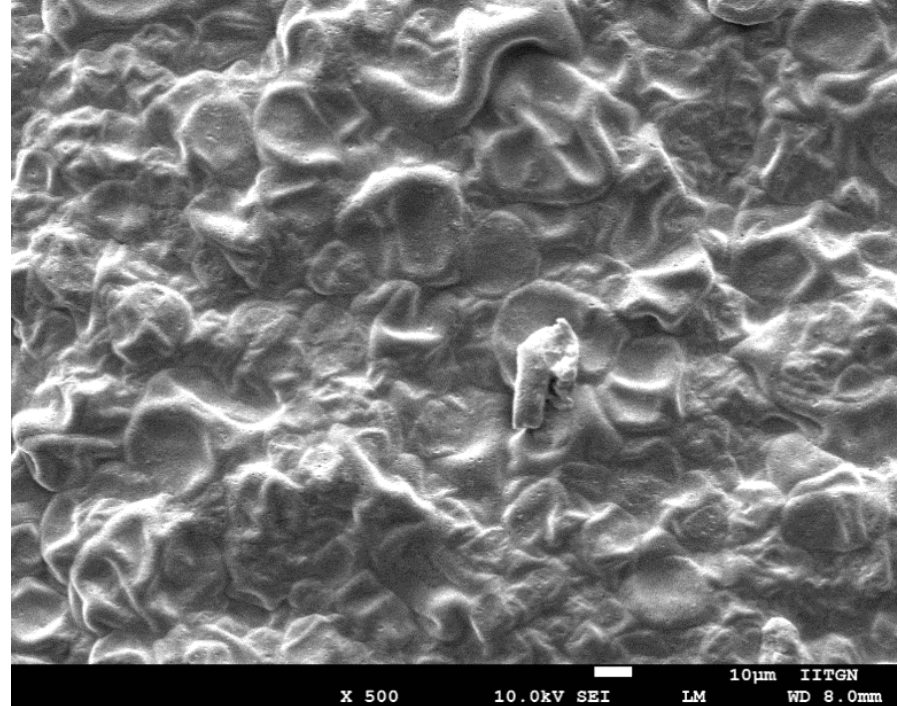
Figure 4. Scanning electron microscopy image of drug-loaded film (F1) at 500× magnification.